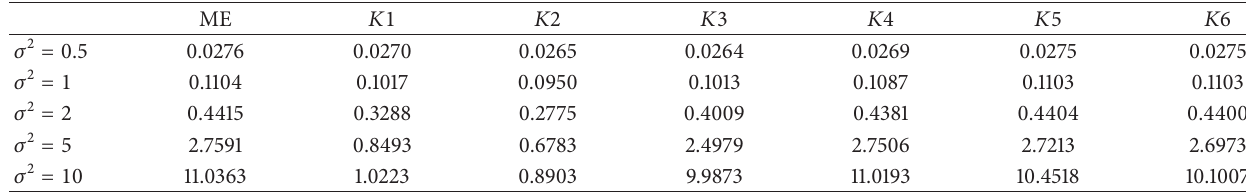
Table 16: Estimated MSE with 𝑛 = 50 , 𝑝 = 6 , and 𝛾 = 0.99